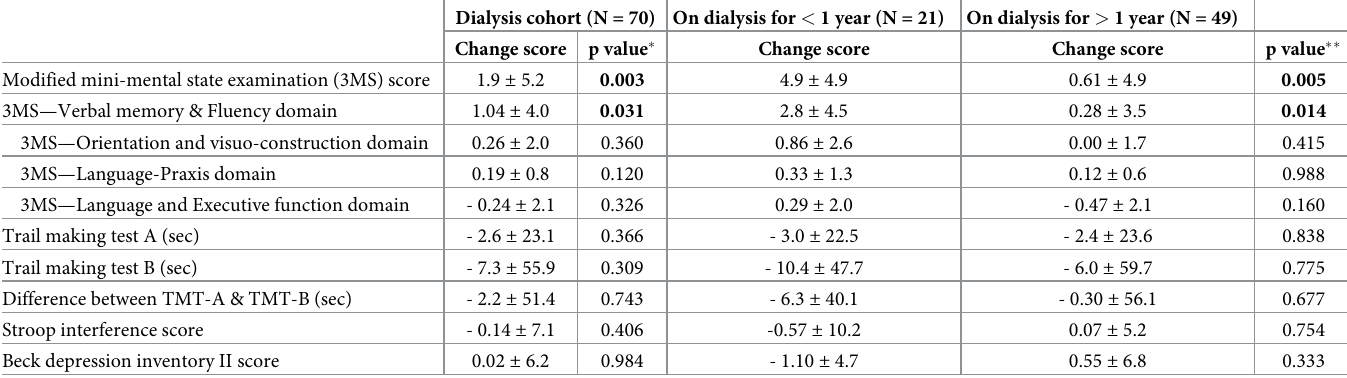
Table 5. Changes in scores of cognitive and psychological measures at follow up compared to baseline for the dialysis cohort and comparison of change scores between patients who commenced dialysis within one year compared to patients who have been on dialysis longer than one